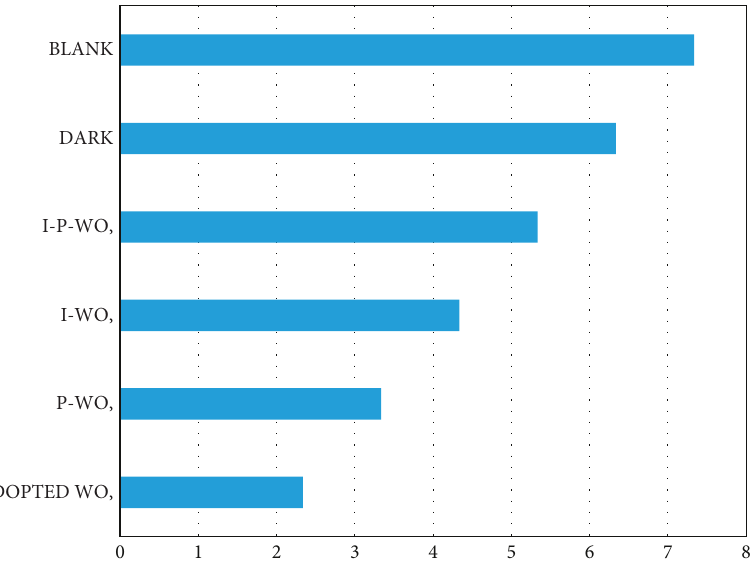
Figure 7: Degradation efficiency of TOC in local dyeing wastewater by WO